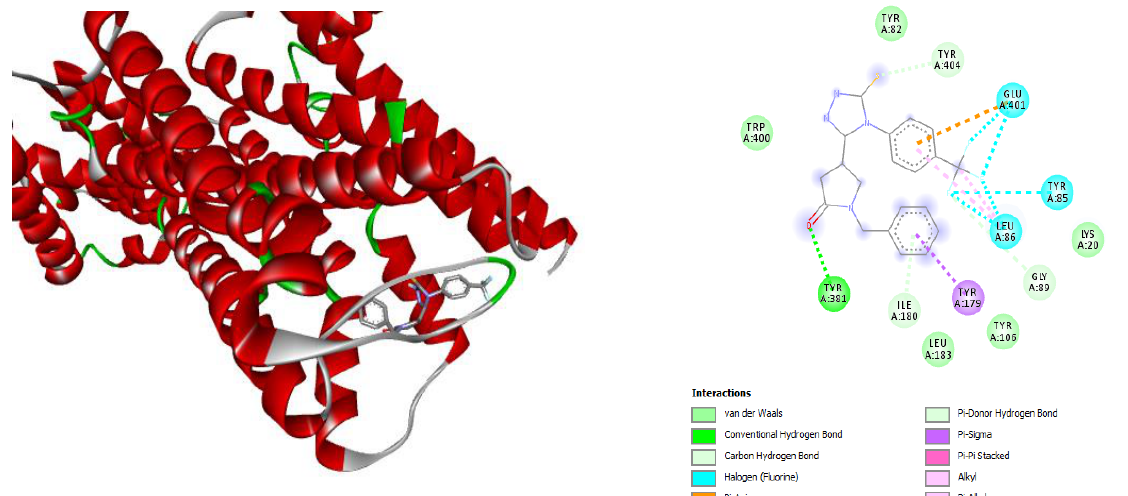
Fig. 4. Superposition of molecule 2 and diagram of intermolecular interactions in complex with muscarinic